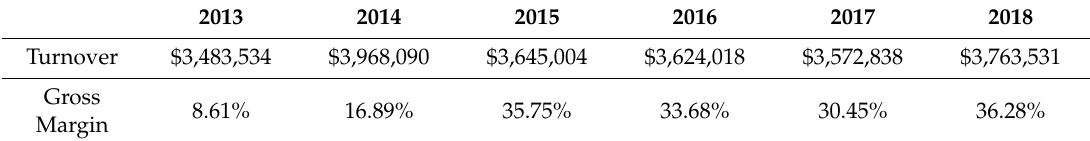
Table 1. Turnover and gross profit margin of Datong Shoe and Materials Company, 2013–2018.